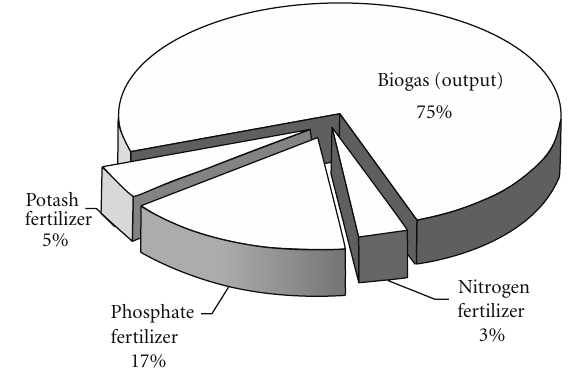
Figure 6: Emergy output ratio of